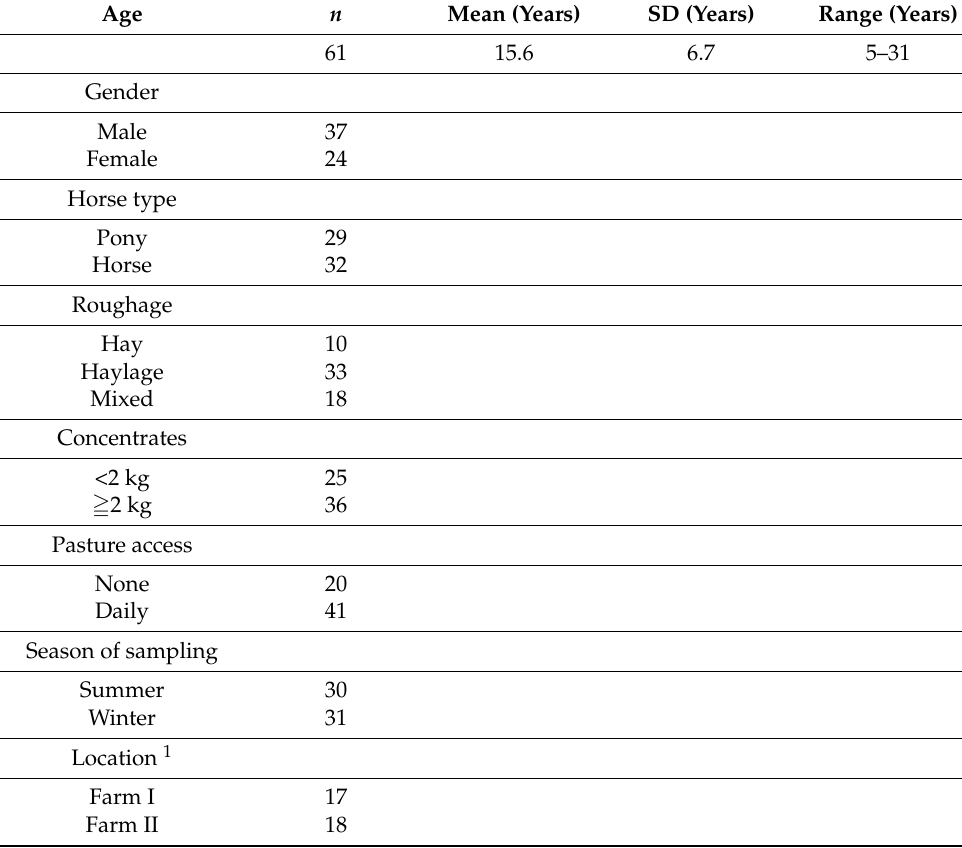
Table 1. Descriptive data of the study